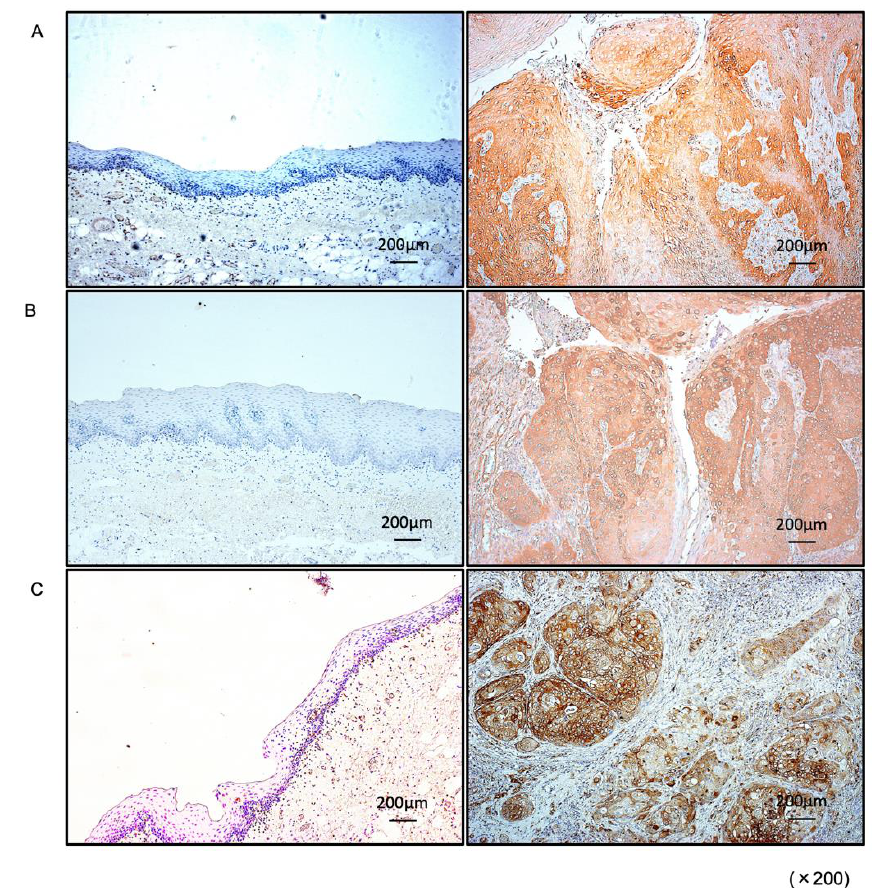
Figure 4. Overexpression of PXN in HNSCC clinical specimens. ( A – C ) Immunohistochemical staining of PXN in HNSCC staining of PXN in HNSCC clinical specimens. PXN expression was high in the nuclei and/or clinical specimens. PXN expression was high in the nuclei and/or cytoplasm of cancer cells (right panels) but weak in cytoplasm of cancer cells (right panels) but weak in normal mucosa (left normal mucosa (left panels).